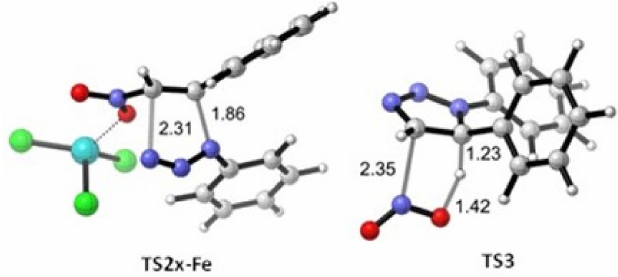
Figure 2. Optimized geometries (B3LYP-D3BJ/Def2SVP) of TS2x-Fe and TS3